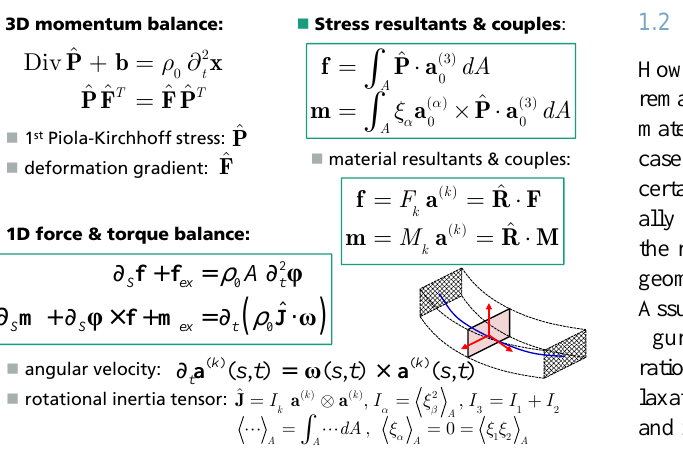
Figure 2. Dynamic equilibrium equations of a Cosserat